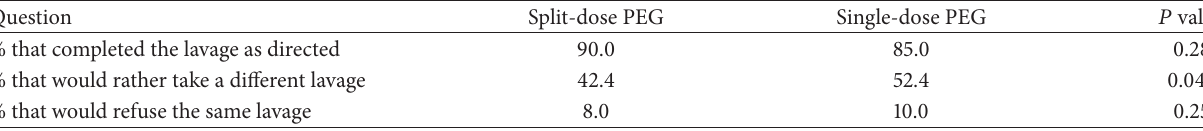
Table 3: Questionnaire: patient opinion regarding the assigned bowel preparation.